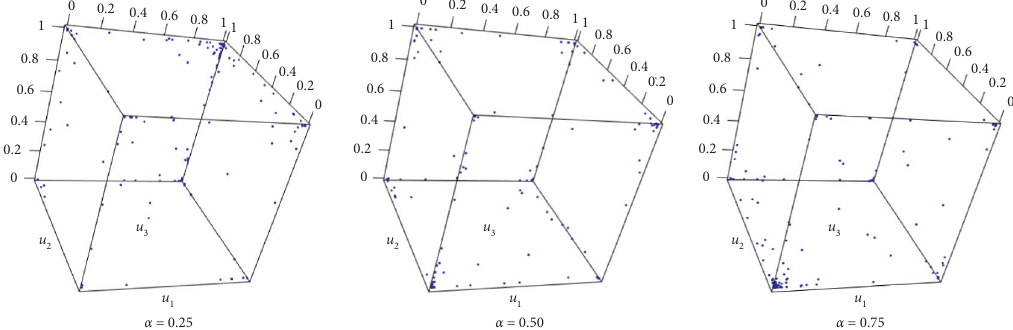
Figure 3: Scatter plots among standardized residuals at α � 0 . 25 (left panel), α � 0 . 50 (middle panel), and α � 0 . 75 (right